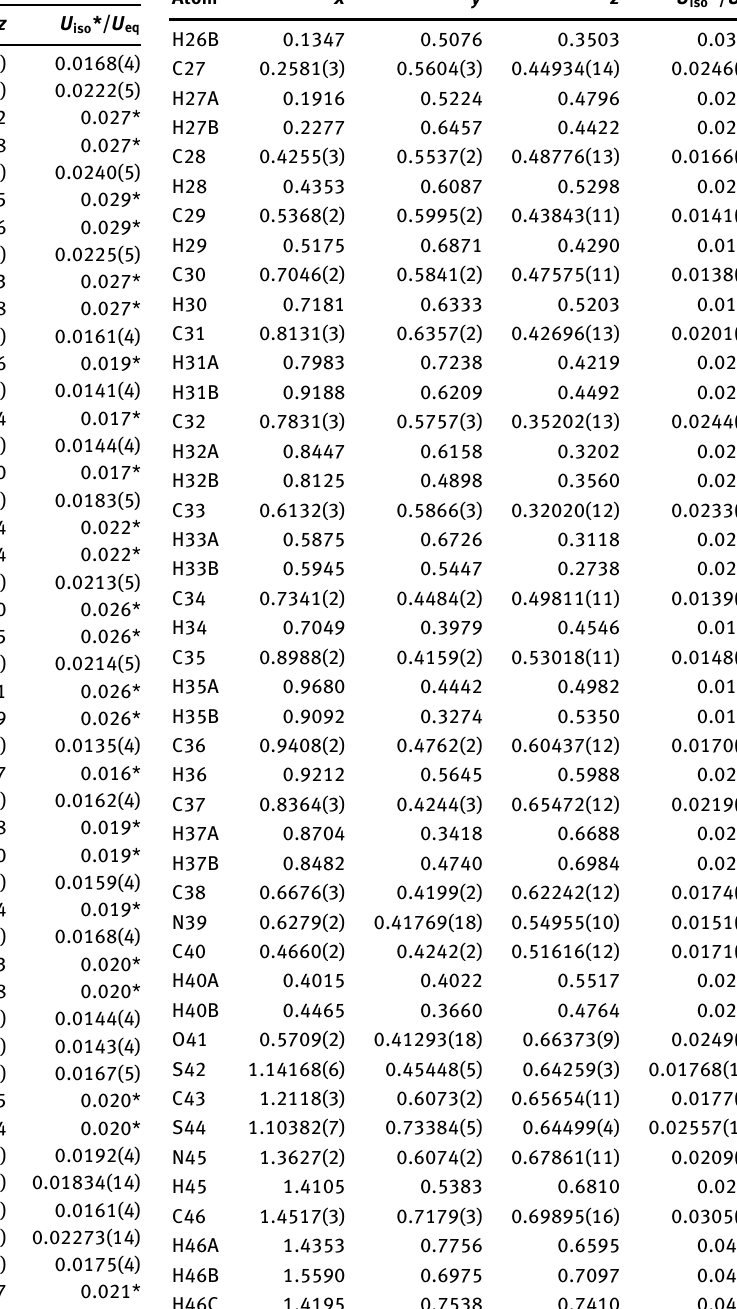
Table 2: Fractional atomic coordinates and isotropic or equivalent isotropic displacement parameters (Å 2